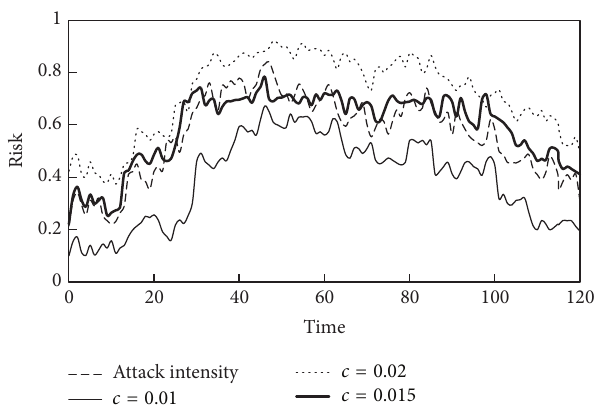
Figure 6: The effect of different initial antibody concentrations for risk values.